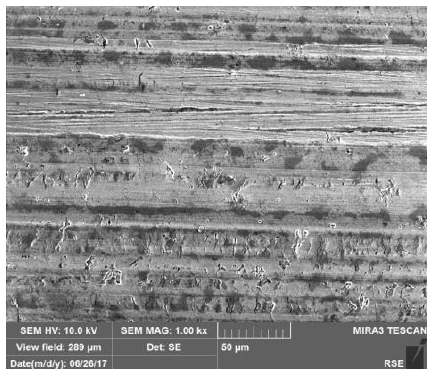
Figure 3. SEM image of the HP surface (SE, 1 kx). The native roughness is well visible. Two different slippery surfaces were prepared: SL-1 and SL-2. In SL-1, the aluminium surface is functionalised with a 1 μm thick layer of oligomeric short alkyl chains whereas SL-2 is a polymeric material formed by interaction among siloxane precursor and PDMS chains and intercalated with the Pluronic. As described in our previous work [27], in SL-1, the coating fills up the voids in the nanostructured layer and the surface is almost totally covered by the coating. On this sur- face, the pseudo-boehmite has a double function: (i) enhancing the adhesion between the substrate and the coating, thanks to the formation of Al–O–Si bonds; and (ii) increasing the porosity of the surface allowing to host a bigger amount of coating respect to an un- treated surface. The SL-2 sample was synthetised by a sol-gel reaction between MTEOS and hydroxy- terminated PDMS in a basic catalyst, followed by the addition of Pluronic. As reported in the literature [28], the basic catalyst leads to the hydrolysis of the Et–O–Si bonds of MTEOS and further, the polycondensation of the hydrolysed silane happens. The polycondensed silane reacts with the terminated HO–Si group of the PDMS, giving rise to a complex multibranched polymeric structure, where silica nanoparticles are branched with PDMS chains, as represented in Figure 4.